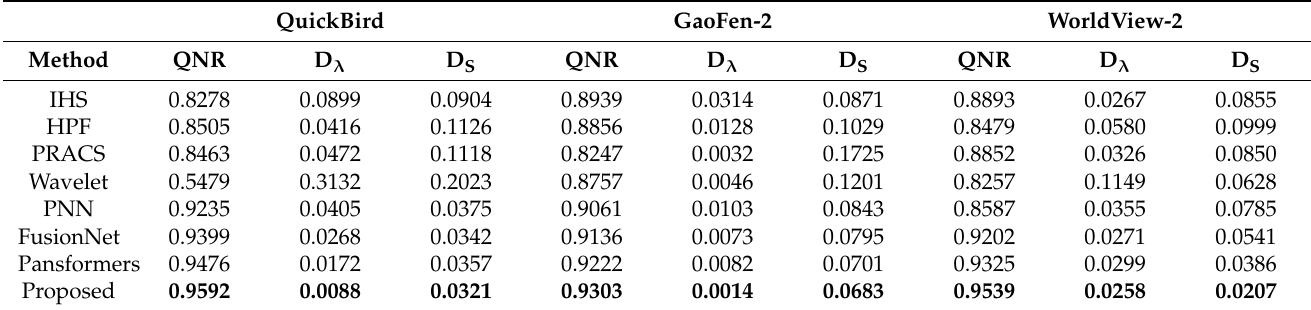
Table 7. Quantitative evaluation of real experiments using the GaoFen-2